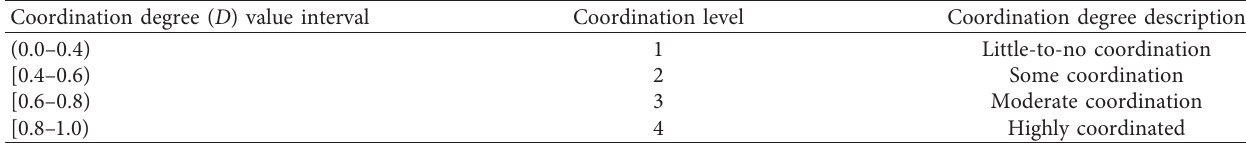
Table 1: Criteria for classification of coupling coordination